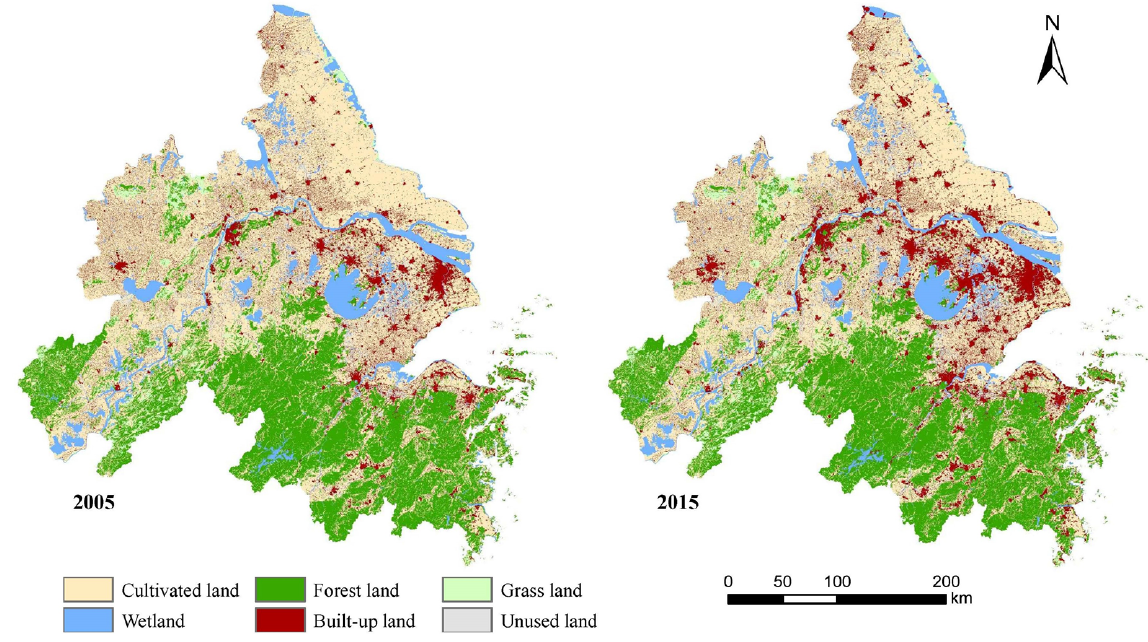
Figure 4. Land cover map of the YRD region in 2005 and 2015.